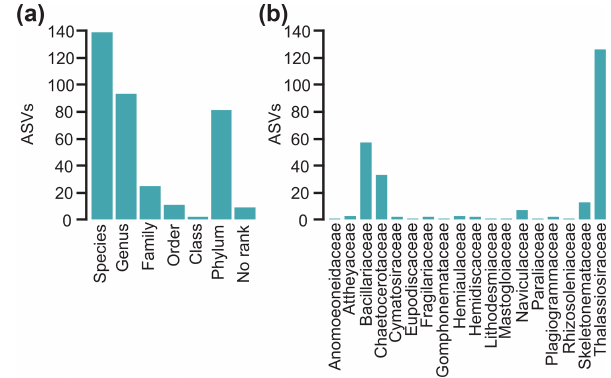
Figure 2. Number of diatom amplicon sequence variants (ASVs) assigned (a) to different taxonomic levels and (b) to different fami-